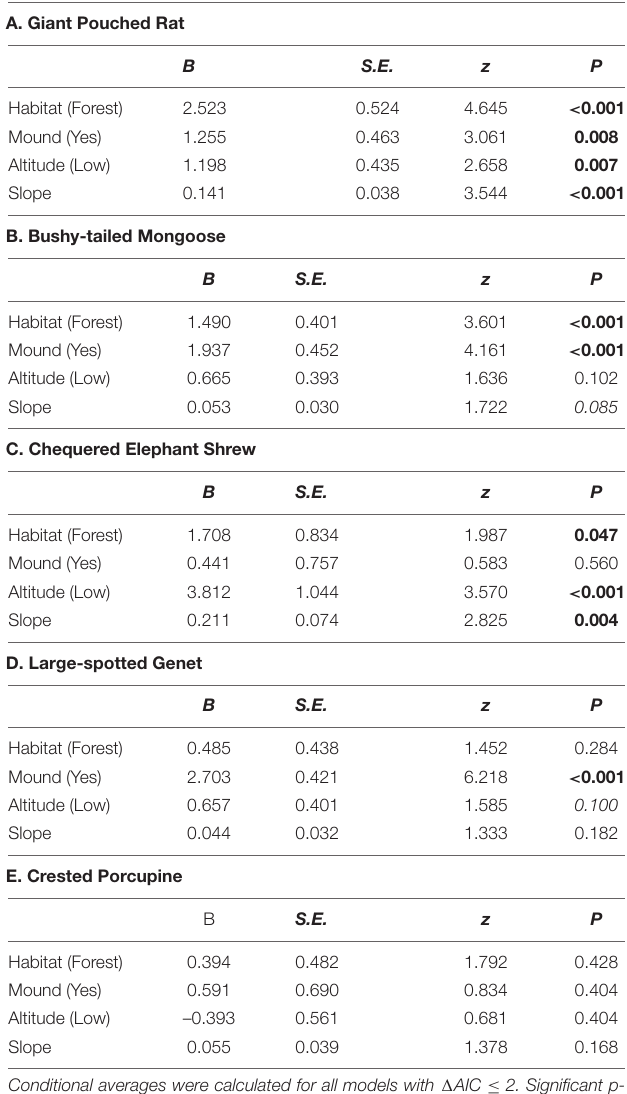
TABLE 2 | Averaged coefficient estimates and significance levels for predictors of relative abundance of five most common meso-mammal species in the Issa Valley, Western